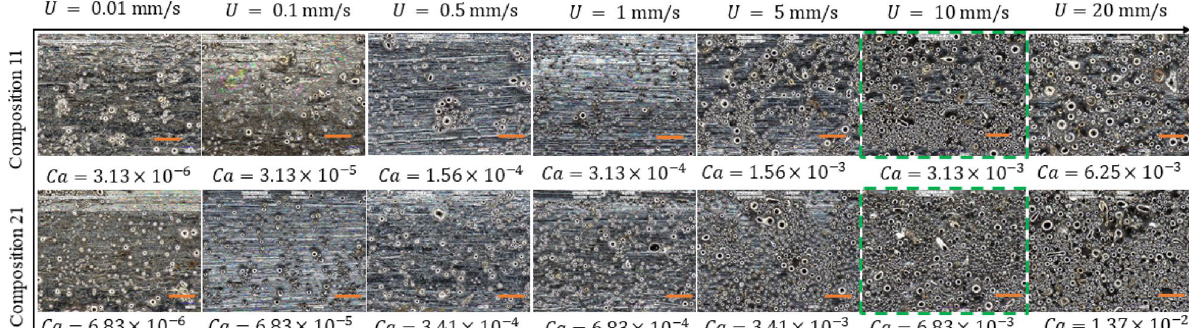
Figure 9. Surface morphology of the coated substrate at different withdrawal velocities at compositions 11 and 21. The picture was taken 1000X zoom. The scale bar is 50 µm. The green outlined images present the particle entrainment on optimized velocity.